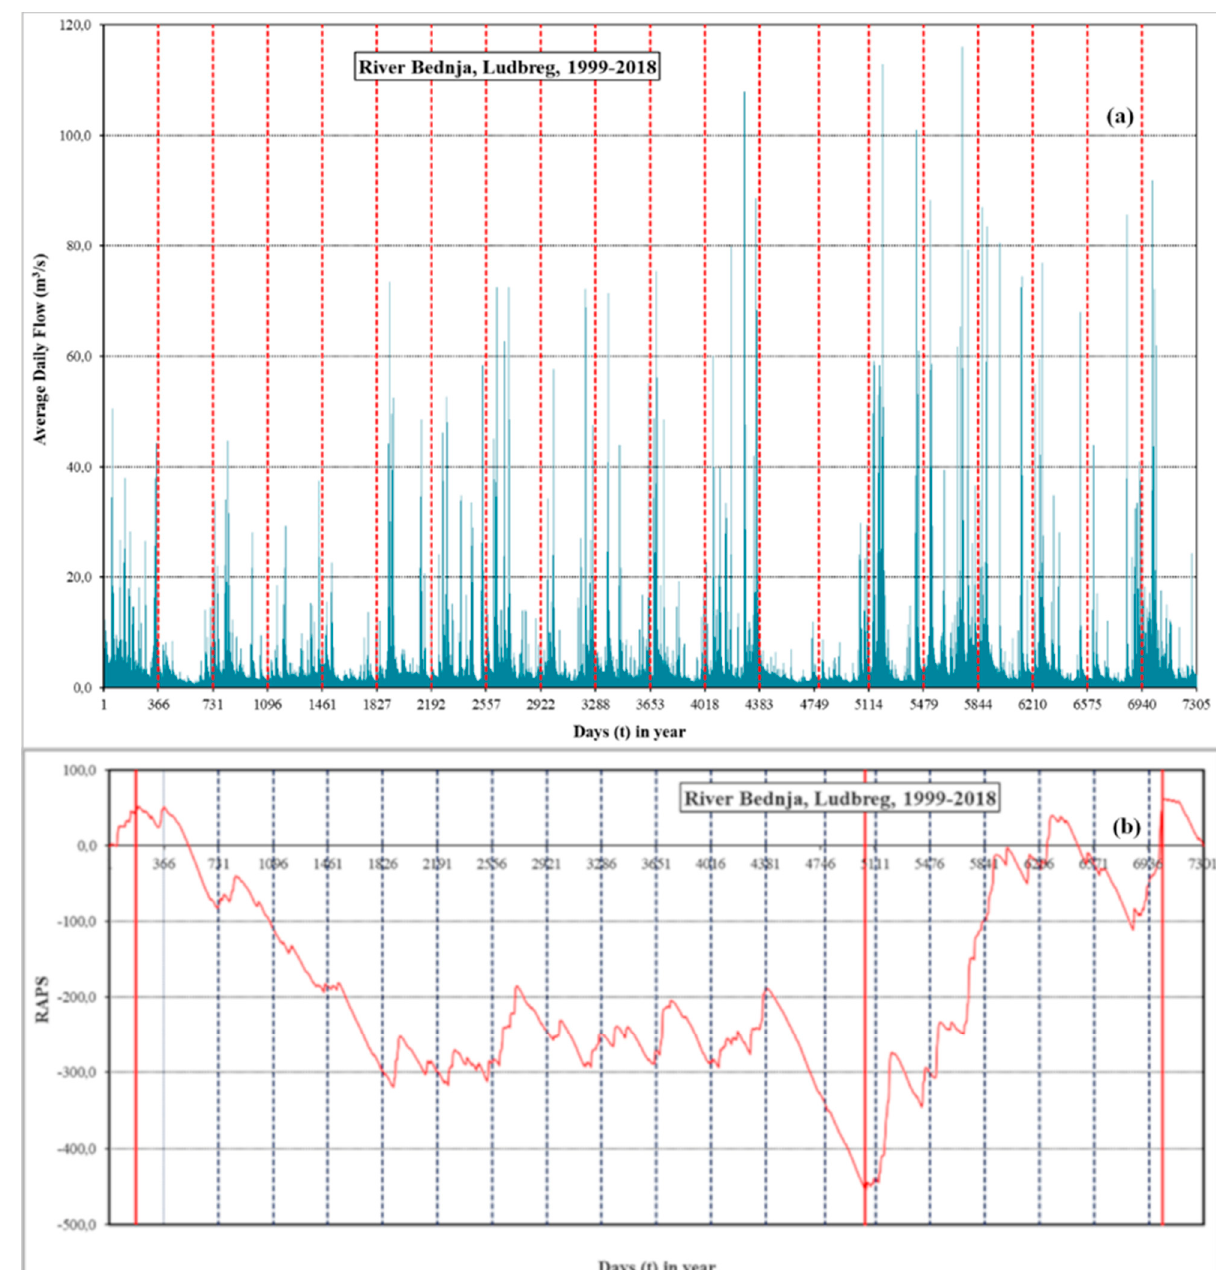
Figure 3. Average daily flows ( a ) and RAPS diagram ( b ) for the Bednja River during the period 1999–2018. The Bednja River shows torrential characteristics, as well as the Gornja Dobra River and Mirna. This is defined by frequent changes of smallest and the biggest values.